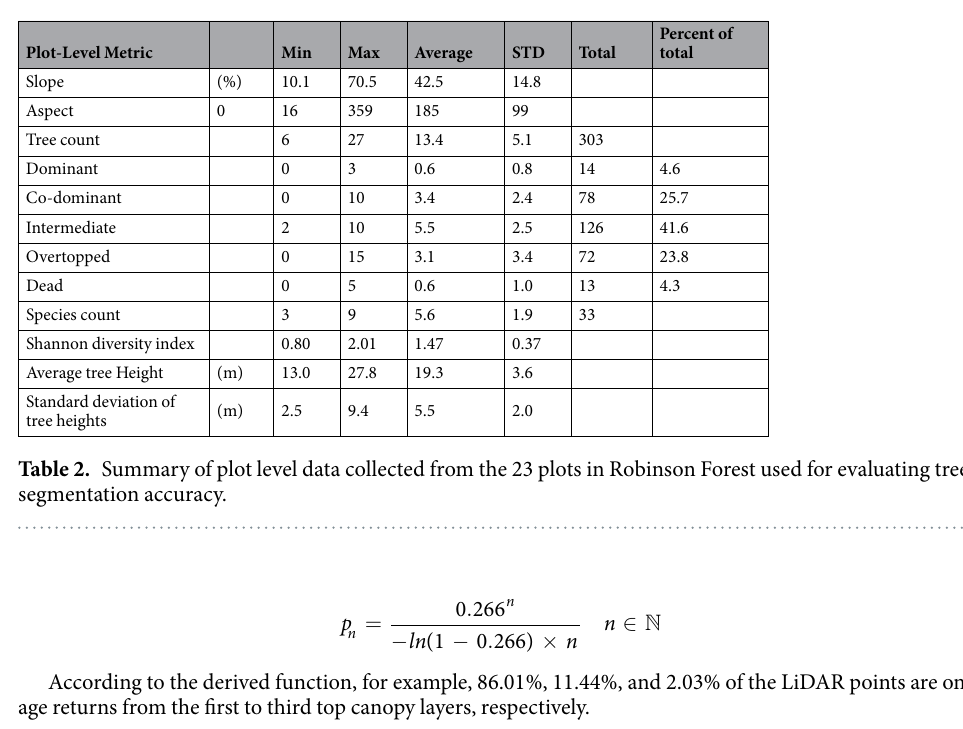
Plot-Level Metric